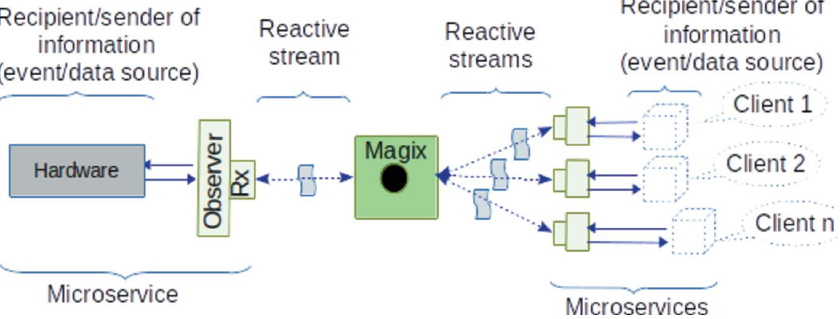
Figure 4 As in Fig. 3, here Magix is a core component responsible for the message flow between counterparts. Each counterpart is a software component or a microservice. Every microservice has its own lifecycle independent from others. The only thing they have in common is that they all attach to a reactive stream produced by Magix using reactive extensions (Rx) and defining observers. Observers ‘glue’ Rx and microservice’s logic.